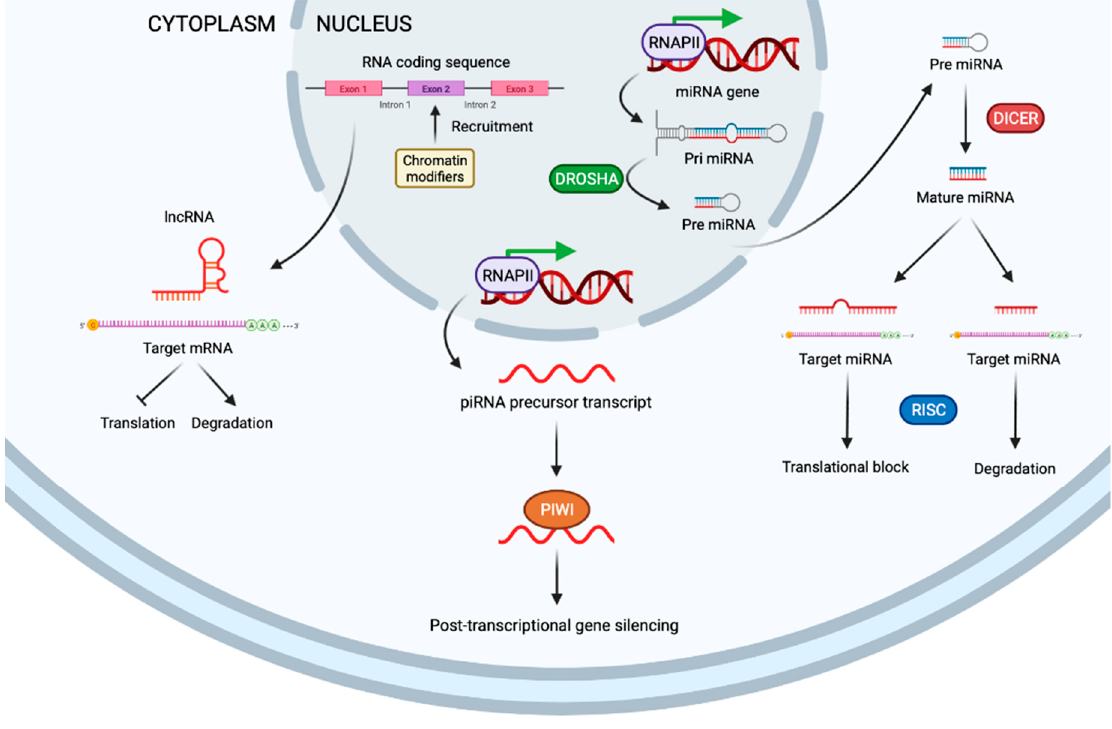
Figure 3. Schematic representation of non-coding RNA. LncRNA targets mRNA to inhibit translation or degrade mRNA (left). PIWI proteins stabilize piRNAs and lead to post-translational control (middle). MiRNA are originated from double- stranded RNA hairpins. The ribonuclease III enzyme, DROSHA, binds and cleaves hairpin structures in primary RNA transcripts into precursor miRNAs. Once transported to cytoplasm, precursor miRNAs are processed by DICER into mature miRNAs that regulate expression of mRNA (right). miRNA: microRNA. DICER: ribonuclease III enzyme. DROSHA: ribonuclease III enzyme. RISC: RNA-induced silencing complex. piRNA: PIWI-interacting RNA.